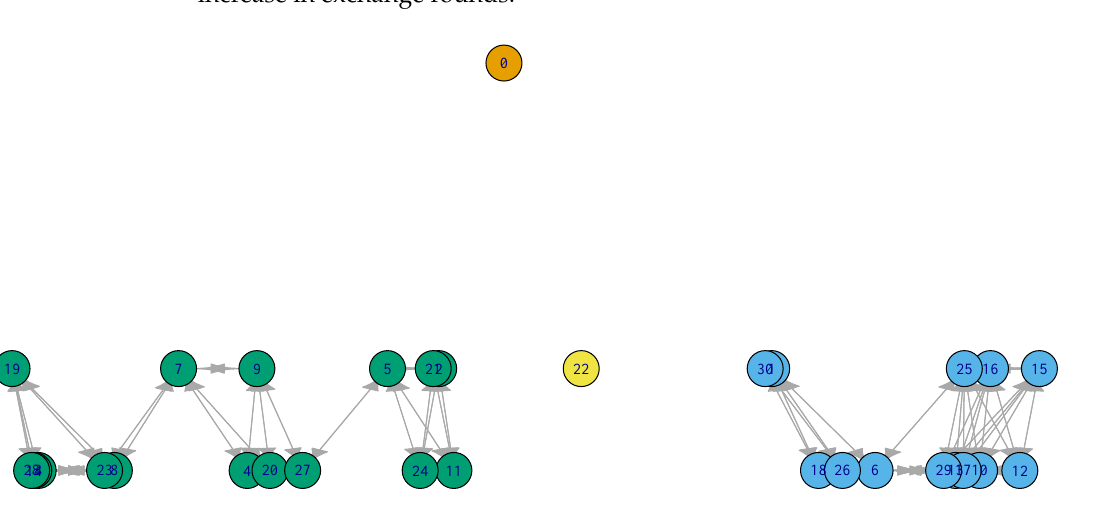
Figure 6. Network topology in Scenario 1 ( node ID 0: